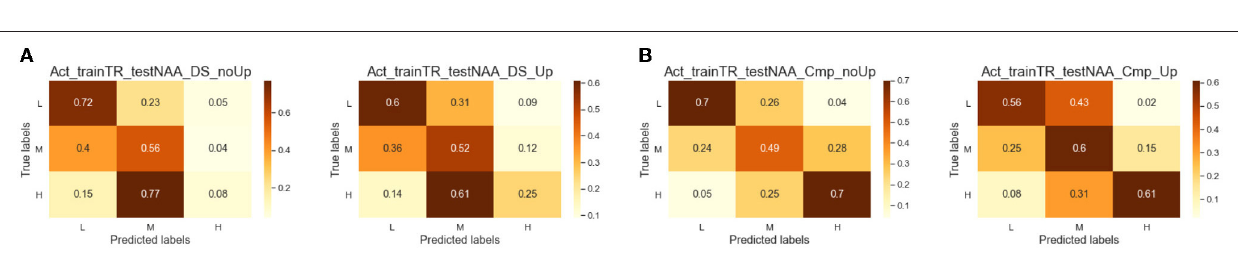
FIGURE 6 | Confusion matrices (in percentage) for training on TR and testing on the actor part of NAA. (A) Experiments using the DEEPSPECTRUM features with no upsampling (left) and upsampling (right). Note a slight increase in recall of the high class for upsampling. (B) Experiments using the COMPARE features with no upsampling (left) and upsampling (right). Note a slight decrease in recall of the high class for